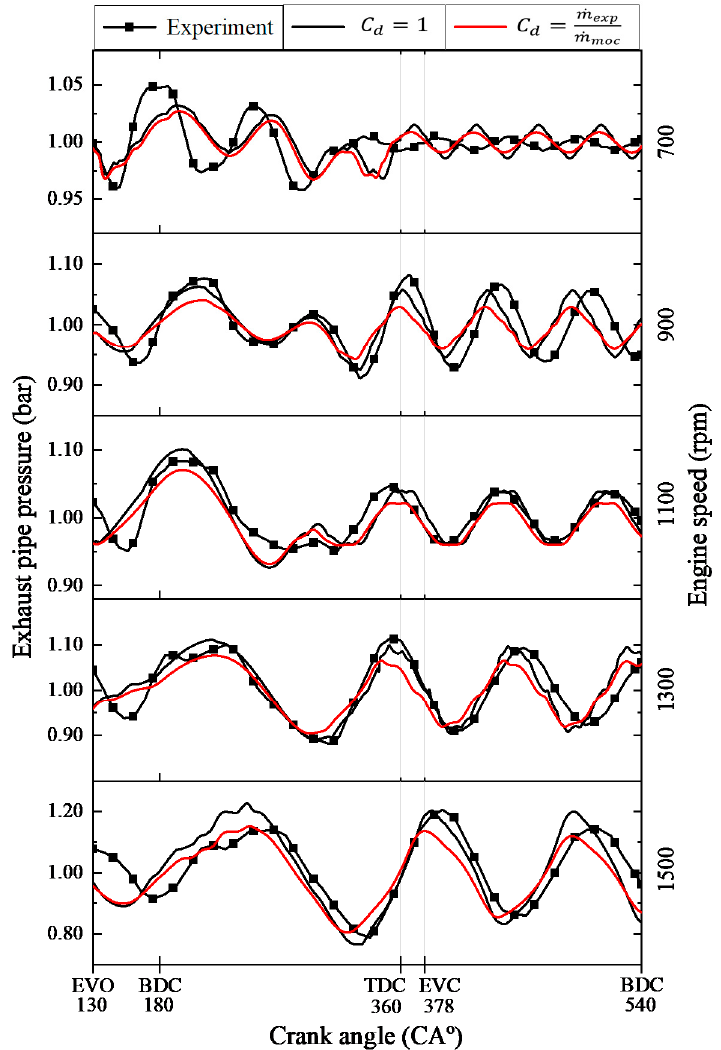
Figure 8. Comparison of the experiment and 1D gas flow analysis results of the exhaust pipe pressure during the exhaust period to the BDC.